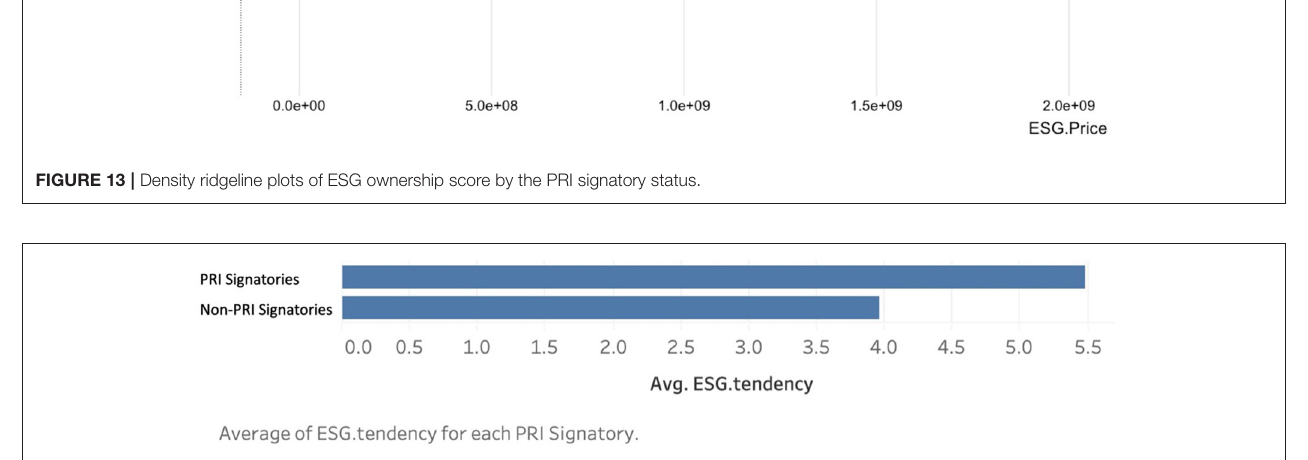
FIGURE 14 | Average ESG tendency by the PRI signatory